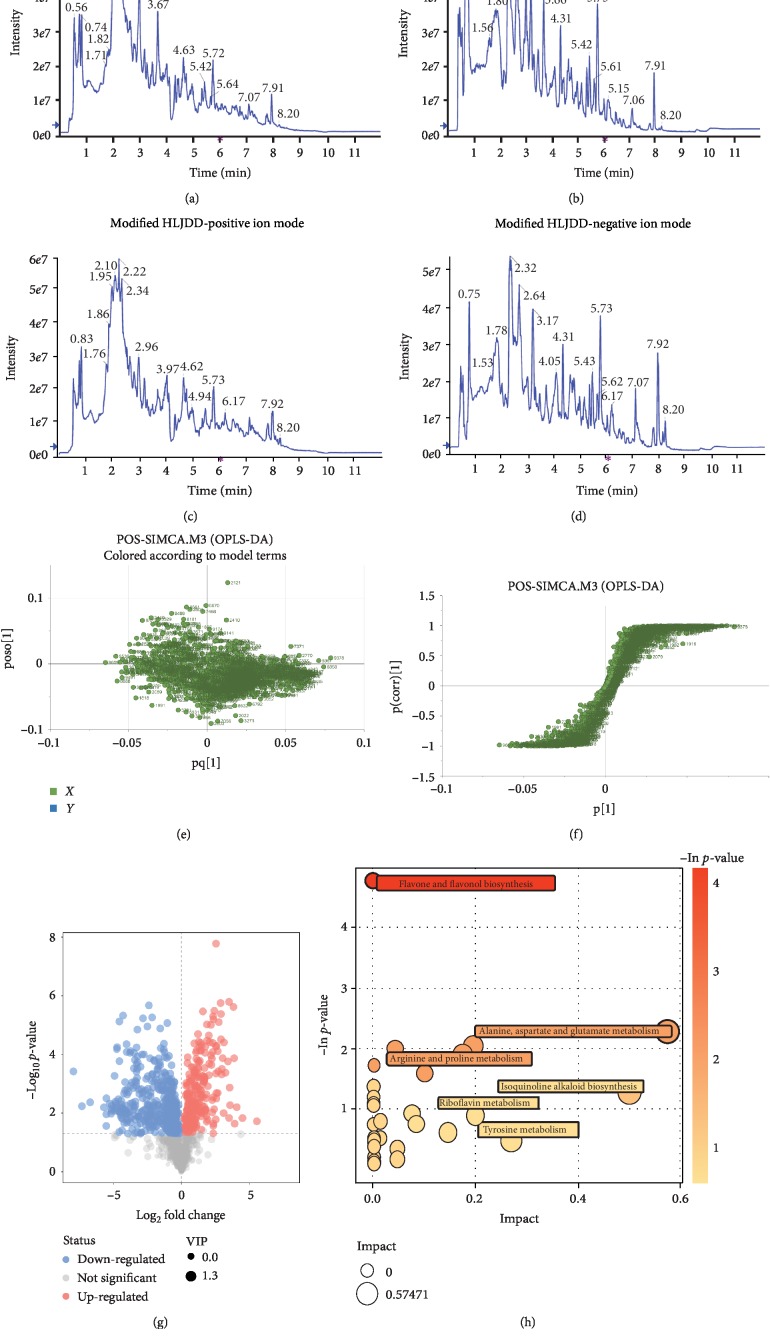
Identification of significant metabolites between HLJDD and modified-HLJDD extract solutions through UPLC-Q-TOF/MS. (a–d) The TCI of HLJDD and modified-HLJDD solutions under positive and negative ion modes. (e, f) Loading plot of PLS-DA and S-plot of OPLS-DA for HLJDD and modified-HLJDD. (g) The volcano plot showing all the significantly changed metabolites between HLJDD and modified-HLJDD solutions. (h) Pathway analysis for HLJDD and modified-HLJDD shown as a bubble plot. All assays were performed in triplicate.